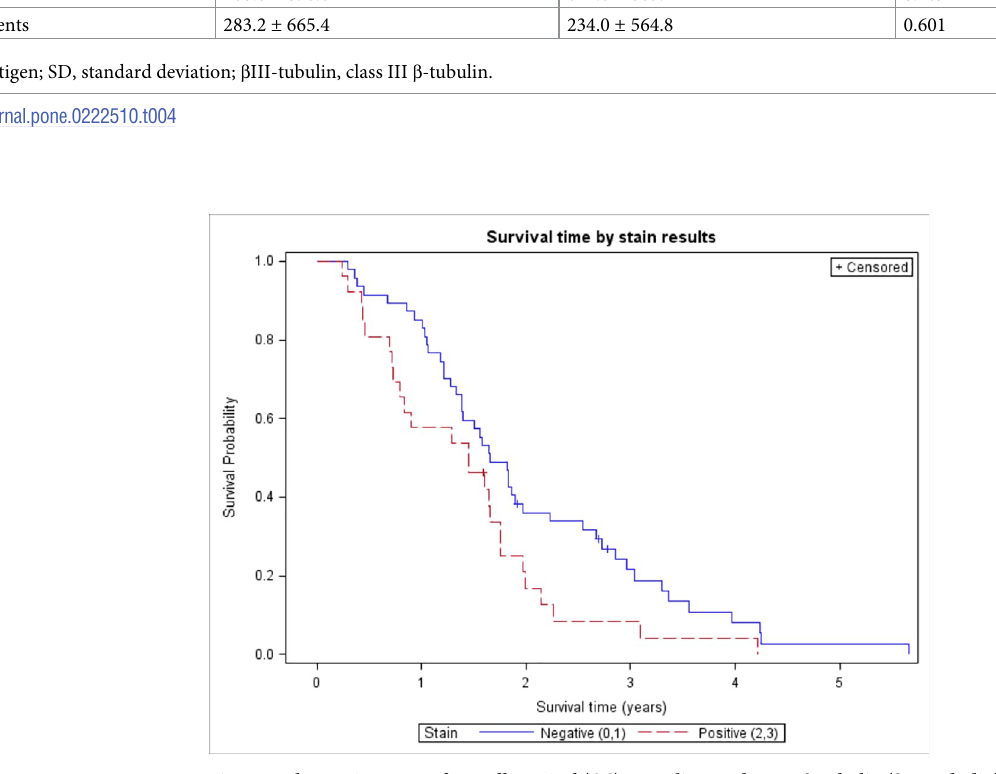
Fig 3. Kaplan-Meier curve of overall survival (OS) according to class III β -tubulin ( β III-tubulin) positivity. Proportion of patients that were alive over time in years from the date of pathological diagnosis. Patients were considered to have low expression if the immunostaining was absent (0) or weak (1+) and high expression if staining was moderate (2+) or strong (3+). Log-rank test of equality showed significantly longer survival time in patient with a low β III-tubulin expression (p = 0.039). Median overall survival was 17.4 months in the high expression group and 19.8 months in the low expression group. The unadjusted HR for OS was 1.69 for the group with a high β III-tubulin expression (95% CI, 1.02–2.80; p =